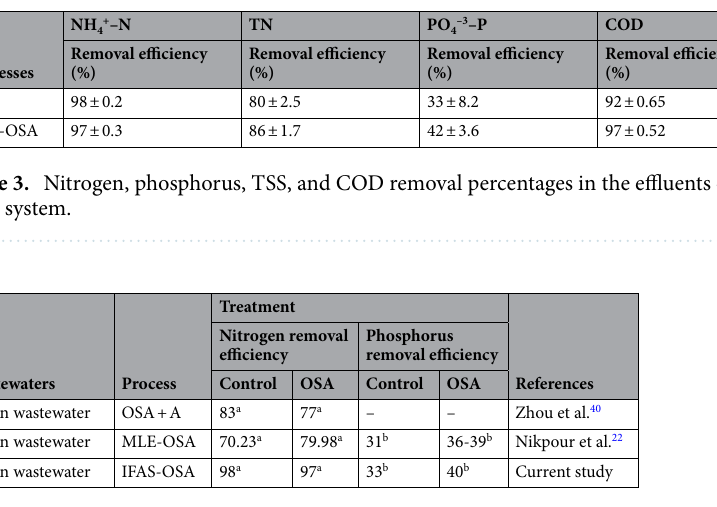
Table 4. The examples of nitrogen and phosphorus removal efficiency (%) reported in previous and the current study. a NH 4+ –N removal. b PO 4–3